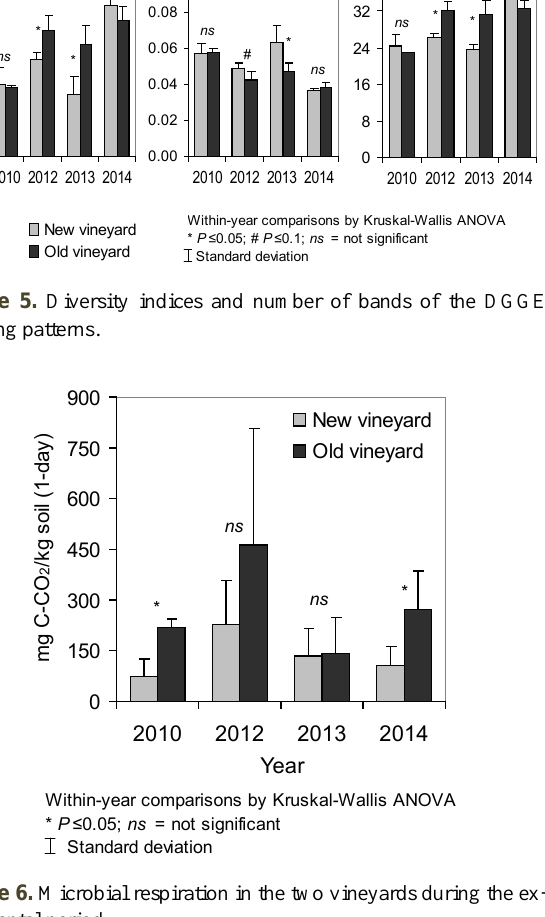
Figure 6. Microbial respiration in the two vineyards during the ex- perimental